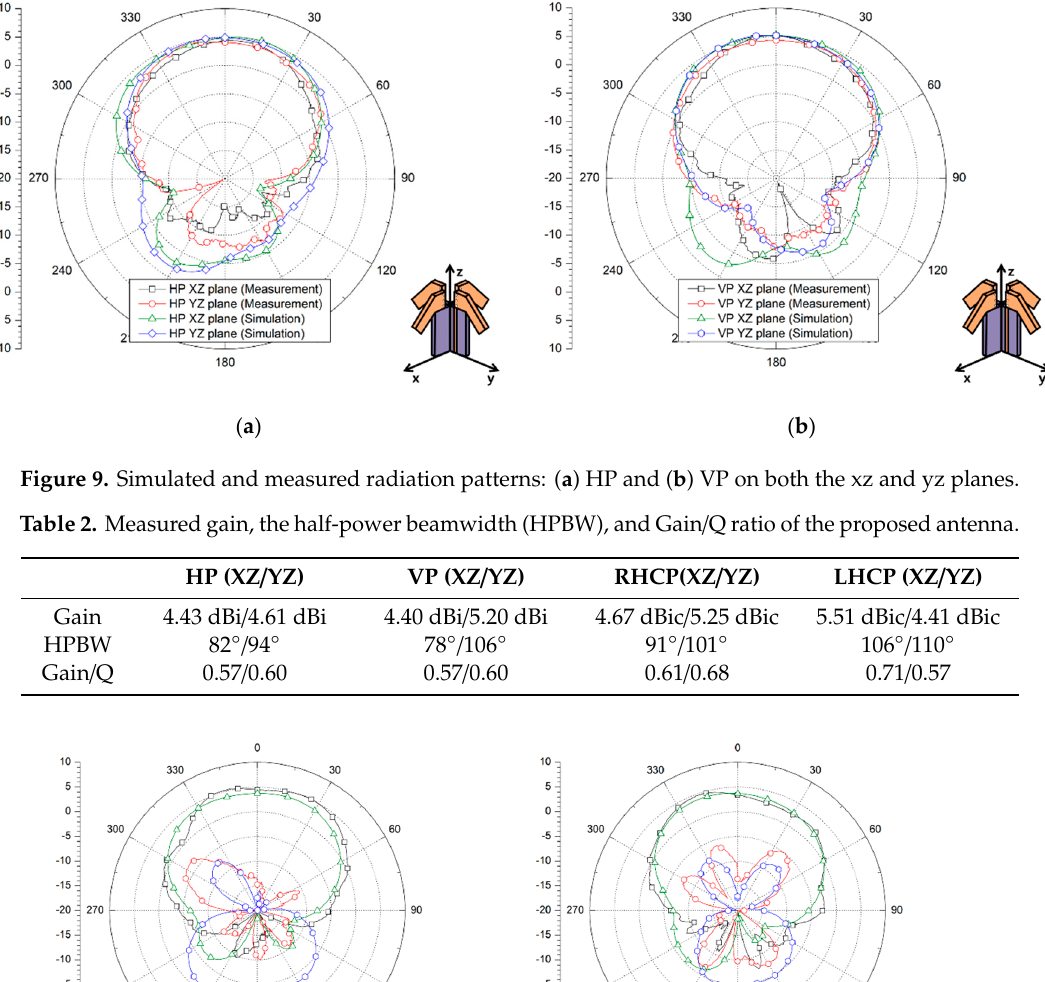
8 of 11 Figure 7. Implementation of the proposed crossed inverted-V antenna for the ( a ) horizontal polarization (HP) and vertical polarization (VP) test, and ( b ) the right-hand circular polarization (RHCP) and the left-hand circular polarization (LHCP) test with an additional 3-dB hybrid coupler. Figure 8 shows the measured return characteristics and isolation characteristics in comparison to the simulation results for the crossed inverted-V antenna. The proposed antenna showed a measured 10-dB impedance bandwidth (IBW) of 752 MHz (5.376 GHz to 6.128 GHz). In addition, the isolation between the HP and VP input ports was about 20 dB at the target frequency of 5.8 GHz. ( a )